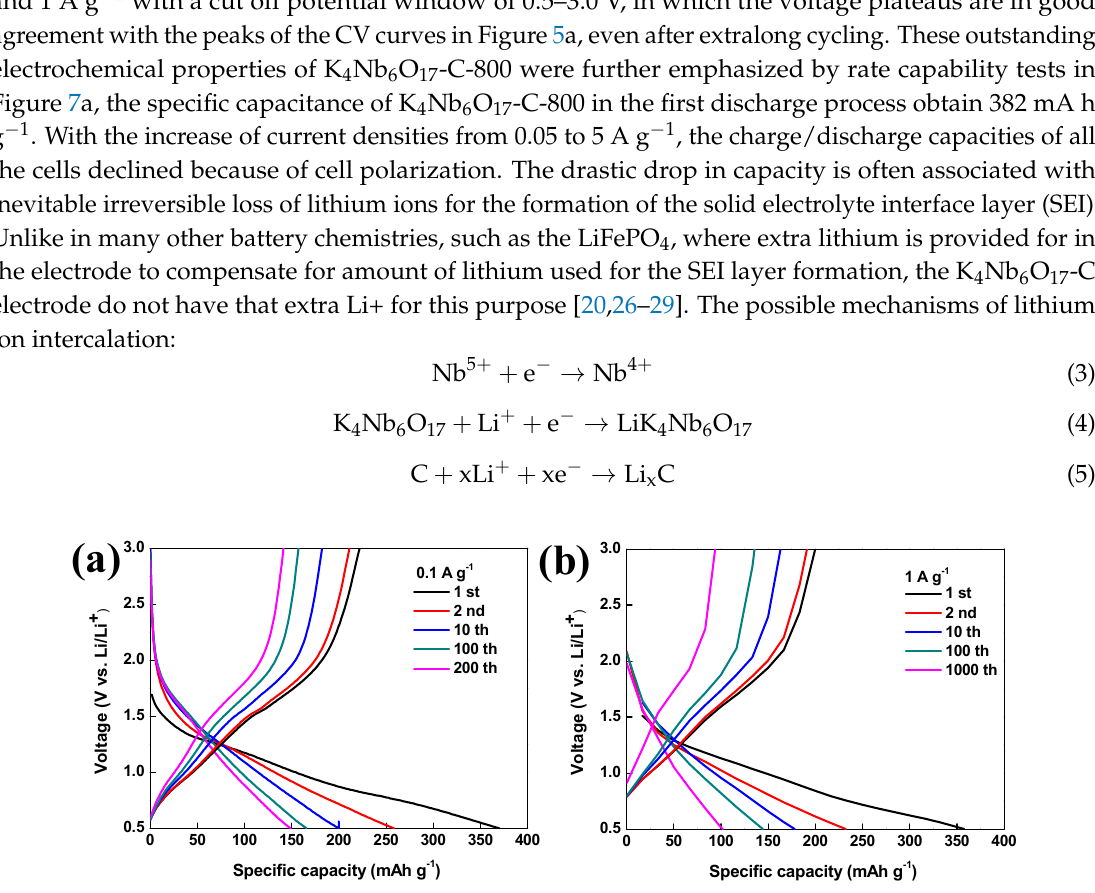
Figure 7. ( a ) Comparison of the capacities in dependence of cycle number of K 4 Nb 6 O 17 -C-800 half-cells at various current densities from 0.05 to 5 A g − 1 . ( b ) The cycling stability of samples at a current density of 0.1 A g − 1 . ( c ) The cycling stability of K 4 Nb 6 O 17 -C-800 at a current density of 0.1, 1, and 5 A g − 1 . ( d ) Nyquist plots of half-cell of the synthesis of K 4 Nb 6 O 17 -C nanosheet. The inset shows that the Nyquist plots of K 4 Nb 6 O 17 -C sample after 200 cycles with a current density of 0.1 A g − 1 . To understand the cycle retention characteristics, Figure 7c gives the cycling test that was conducted at 0.1 A g − 1 . Despite that some capacity decreased after 200 cycles, the K 4 Nb 6 O 17 -C-800 electrode still preserved a discharge capacity of approximate 150 mA h g − 1 , correspond approximately 84% of the 20th cycle (201 mA h g − 1 ), and the coulombic efficiency was excellent (100.6%). It should be emphasized that the specific capacity of K 4 Nb 6 O 17 -C-800 was also superior to those of many reported Nb 2 O 5 nanomaterials (see comparison in Table 1). Semicircle areas in the Nyquist plots at different frequencies refer to different aspects of electrochemical. Semicircle at high frequency represents the contact resistance, and that at medium frequency represents the charge transfer resistance. The straight line at low frequency represents the mass transfer of Li-ions [26]. As shown